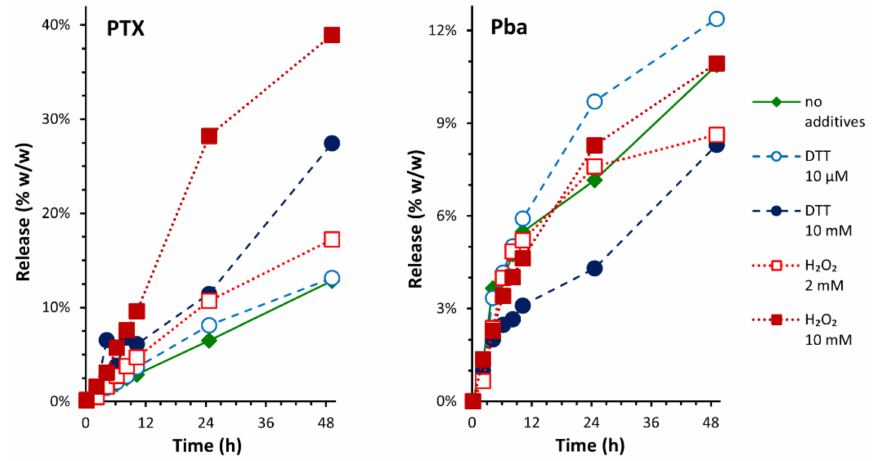
Figure 3. Release profiles of PTX and Pba from MAL -PTX 2 S@Pba NPs in different redox conditions, as determined by equilibrium dialysis and HPLC–UV analysis. Diamonds: redox-neutral; empty circles: mildly reducing; filled circles: strongly reducing; empty squares: mildly oxidizing; filled squares: strongly oxidizing. Redox conditions are described in detail in the Experimental section (Section 2.5).